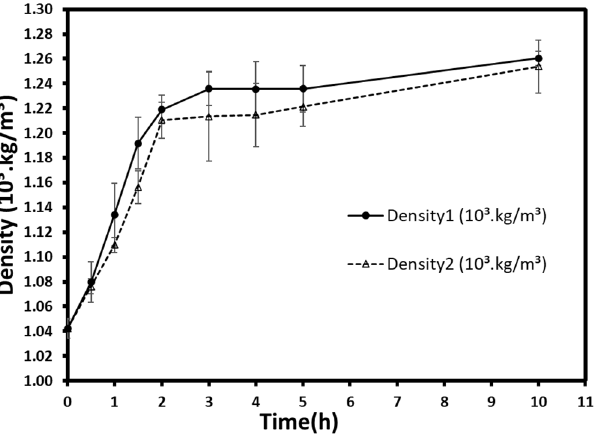
Figure 5. Density evolution during osmotic dehydration at atmospheric (density 1) and vacuum (density 2) pressures. Each point represents the mean and standard deviation of a duplicate of three repetitions.